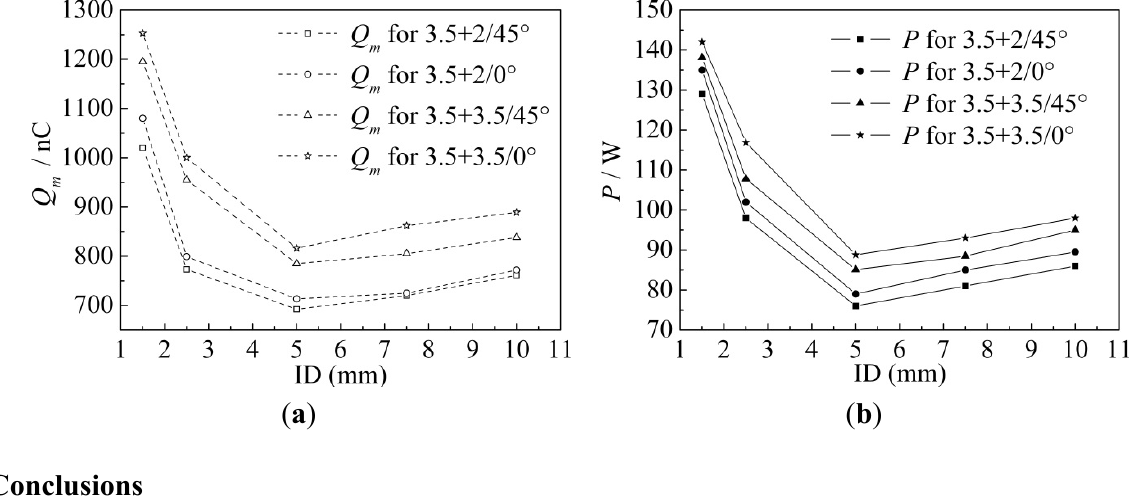
Figure 12. Experimental results at 10.6 kV: ( a ) Transported charges per cycle Q for the four configurations using Lissajous figures as a function of ID; ( b ) Discharge power P obtained for the four configurations using Lissajous figures as a function of